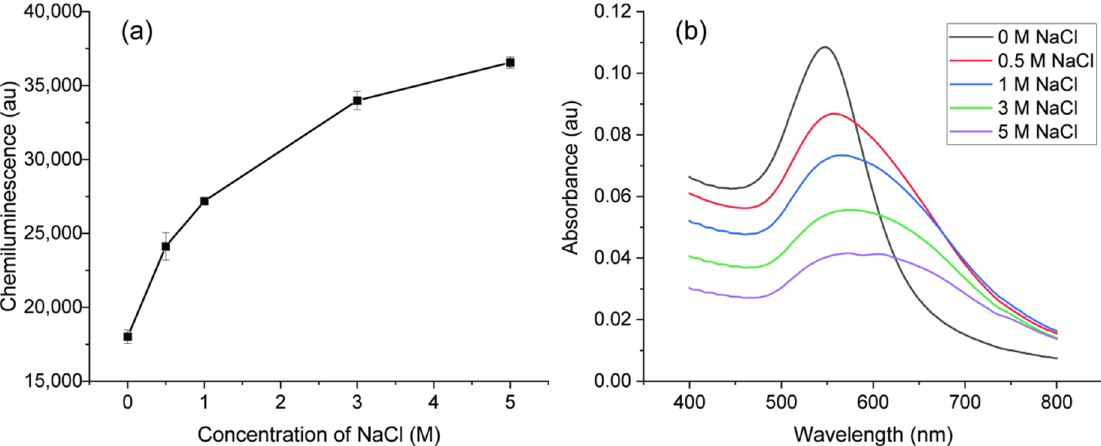
Figure 8. ( a ) Effects of NaCl concentration on the CL intensity; ( b ) UV − Vis spectra of the AuNPs with different concentration of NaCl.